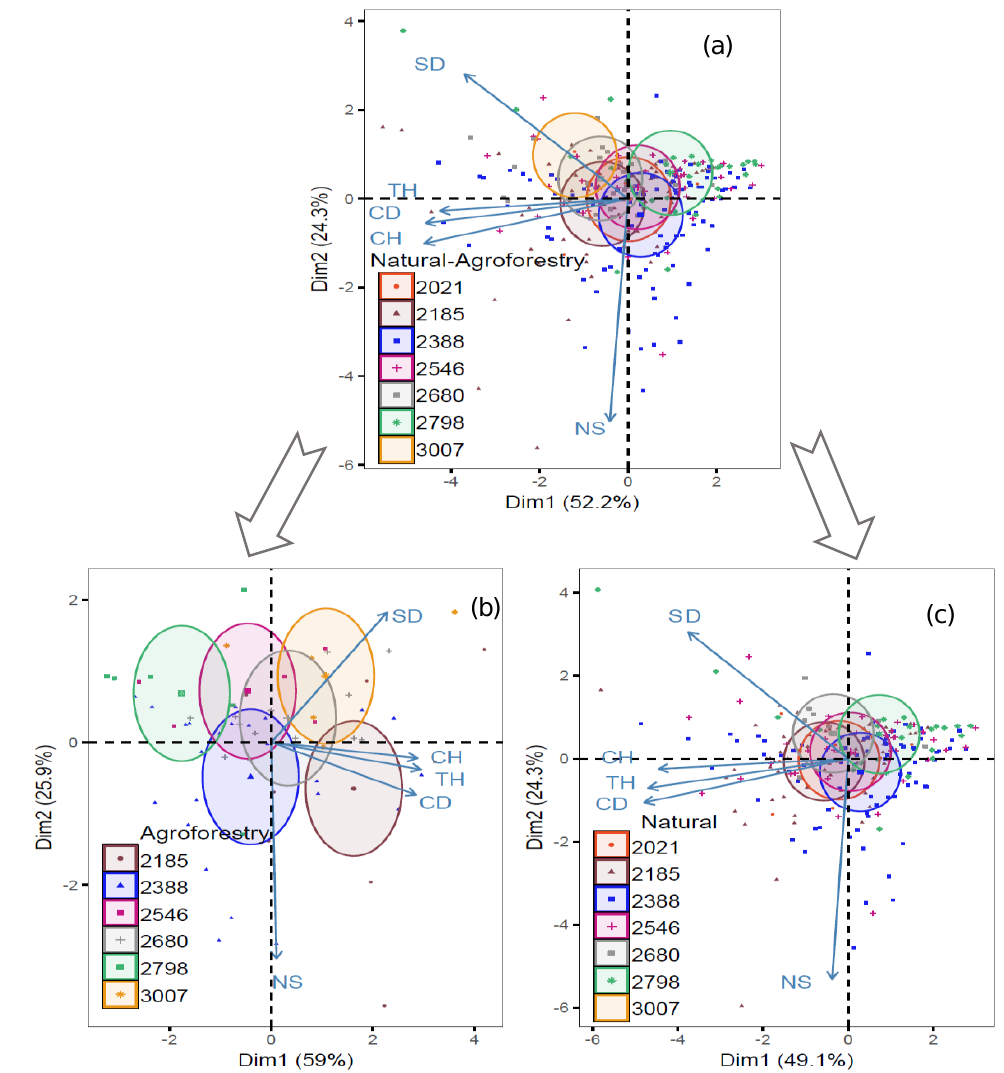
Figure 3. Principal component analysis (PCA) of number of stems (NS), crown diameter (CD), tree height (TH), crown height (CH), and stem diameter (SD) of Tara. Natural and agroforestry environments ( a ), altitudes for agroforestry environments ( b ), and altitudes for natural environments ( c ).